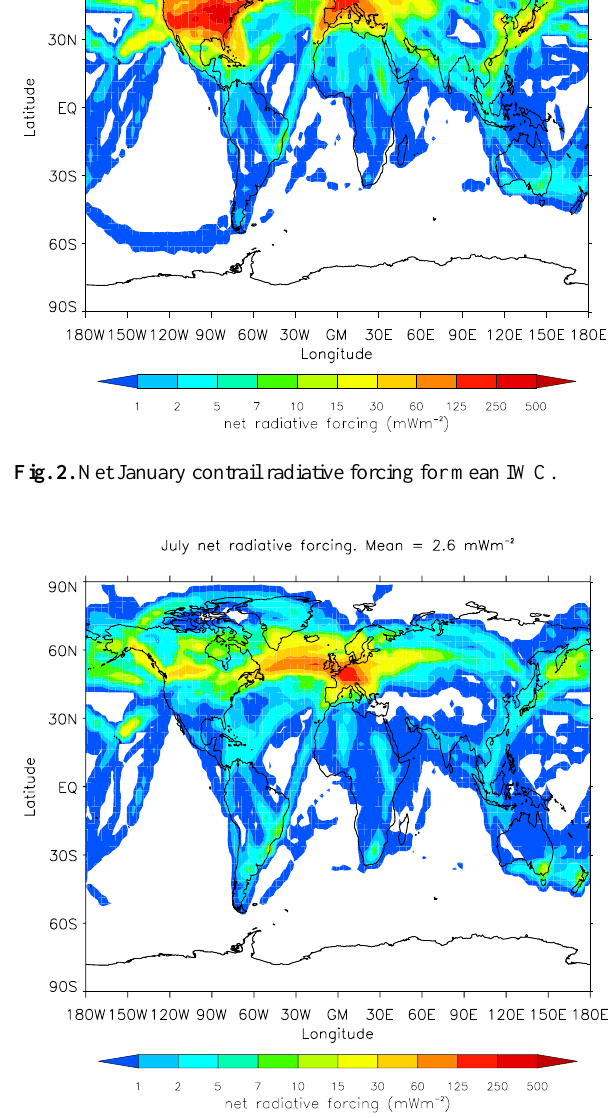
Fig. 3. Same as Fig. 1 but for July.